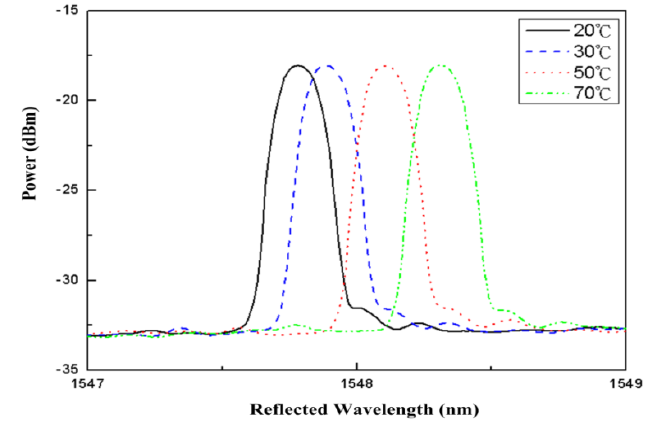
Figure 2. Center wavelength of the FBG at various